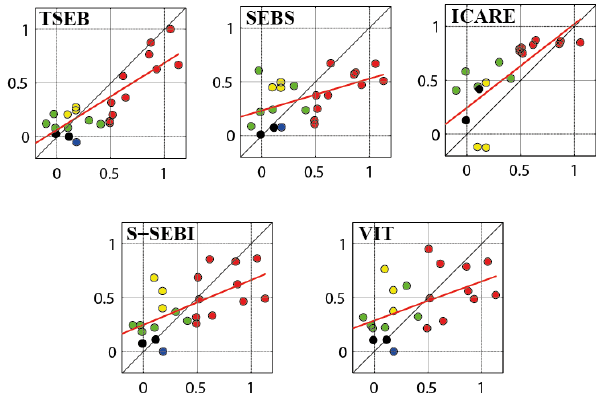
Fig. 9. Scatter plots of water stress at each station for TSEB, SEBS, S-SEBI, VIT method and ICARE. Values calculated for ASTER overpass dates. Color code: red: LAI < 0.4; yellow: 0.4 ≤ LAI < 0.8; green: 0.8 ≤ LAI < 1.2; navy-blue: 1.2 ≤ LAI < 2.0; black: LAI ≥